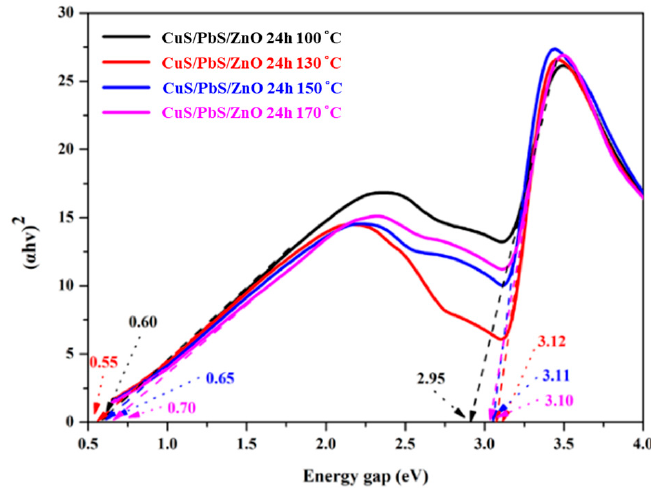
Figure 4. Tauc plot of CuS/PbS/ZnO photocatalysts prepared at various hydrothermal temperatures. Electron–hole pair recombination in the photocatalyst was investigated by PL spectral analysis. When the photocatalyst absorbs light energy, the electrons will transition from the ground state to the excited state, and the electrons will fall back to the ground state and generate fluorescence. This process is termed electron–hole pair recombination. The degree of electron–hole recombination in the photocatalyst determines the fluorescence intensity [29].